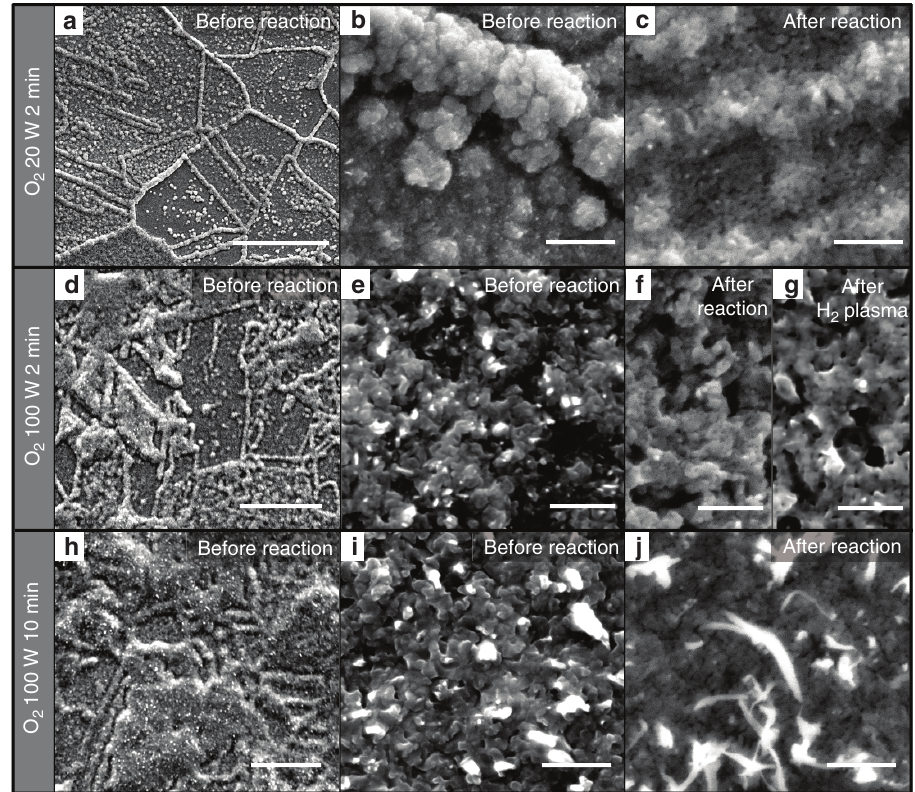
Figure 1 | Morphological characterization of plasma-treated Cu foil electrodes. SEM images of Cu foils treated with O 2 plasma for ( a – c ) 20W 2min; ( d – g ) 100W 2min; and ( h – j ) 100W 10min. ( a , b , d , e , h , i ) The morphology of the as-prepared foils. ( c , f , j ) The morphology after the CO 2 RR reaction. ( g ) The sample plasma treated with O 2 at 100W for 2min after an additional H 2 plasma treatment at 100W for 10min. Scale bars, ( a ) 10 m m; ( b , c , e – g , i , j ) 500nm; ( d , h ) 20 m m.